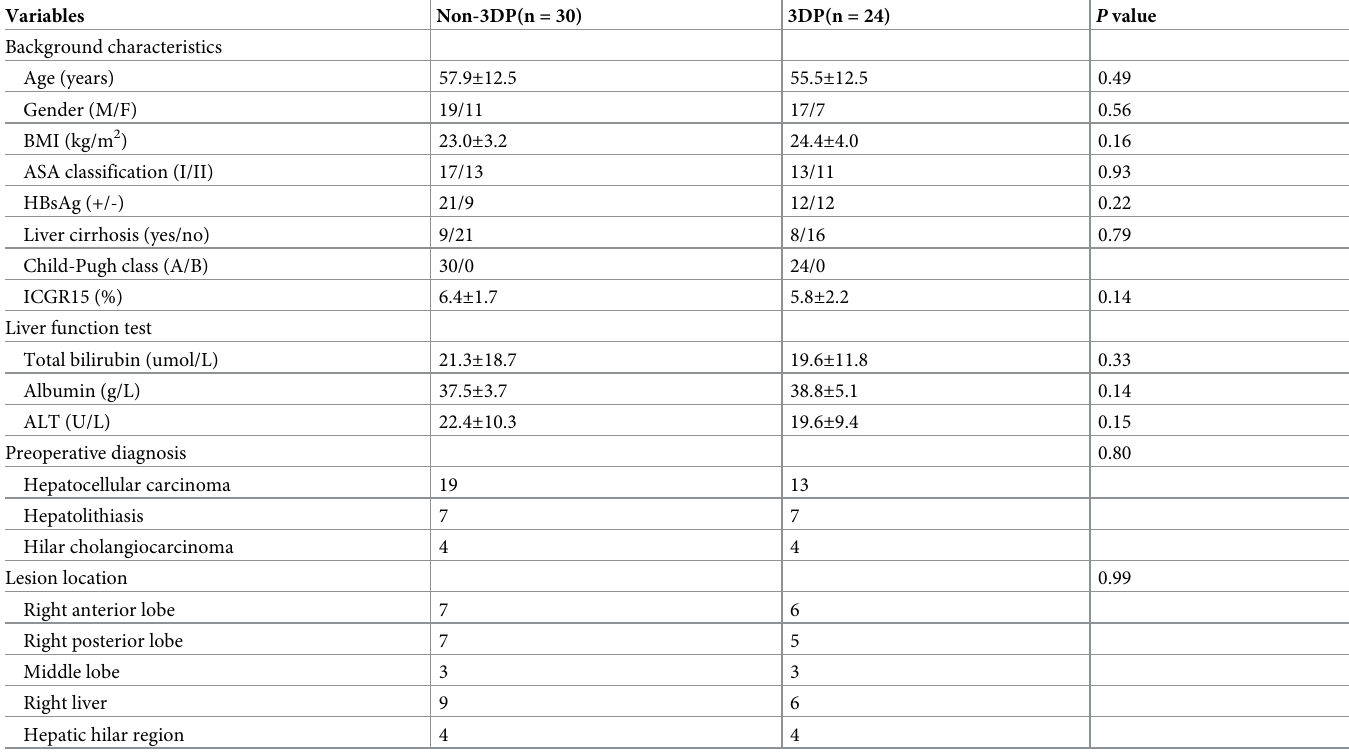
Table 1. Demographics and preoperative characteristics of the non-3DP and 3DP groups.